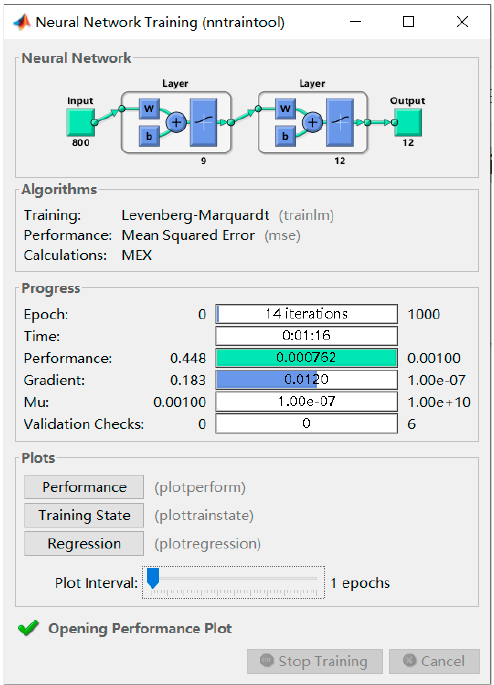
Figure 19. Neural network training model.